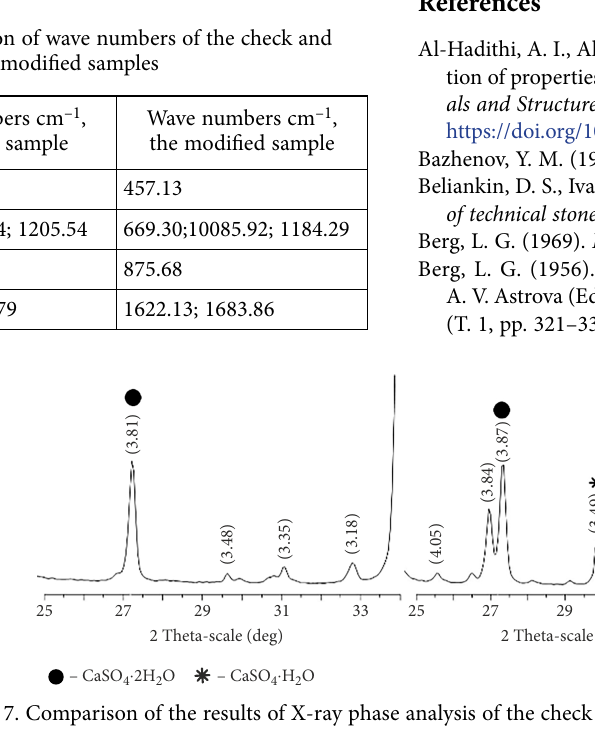
(red), 7.5% of technical sulfur being added